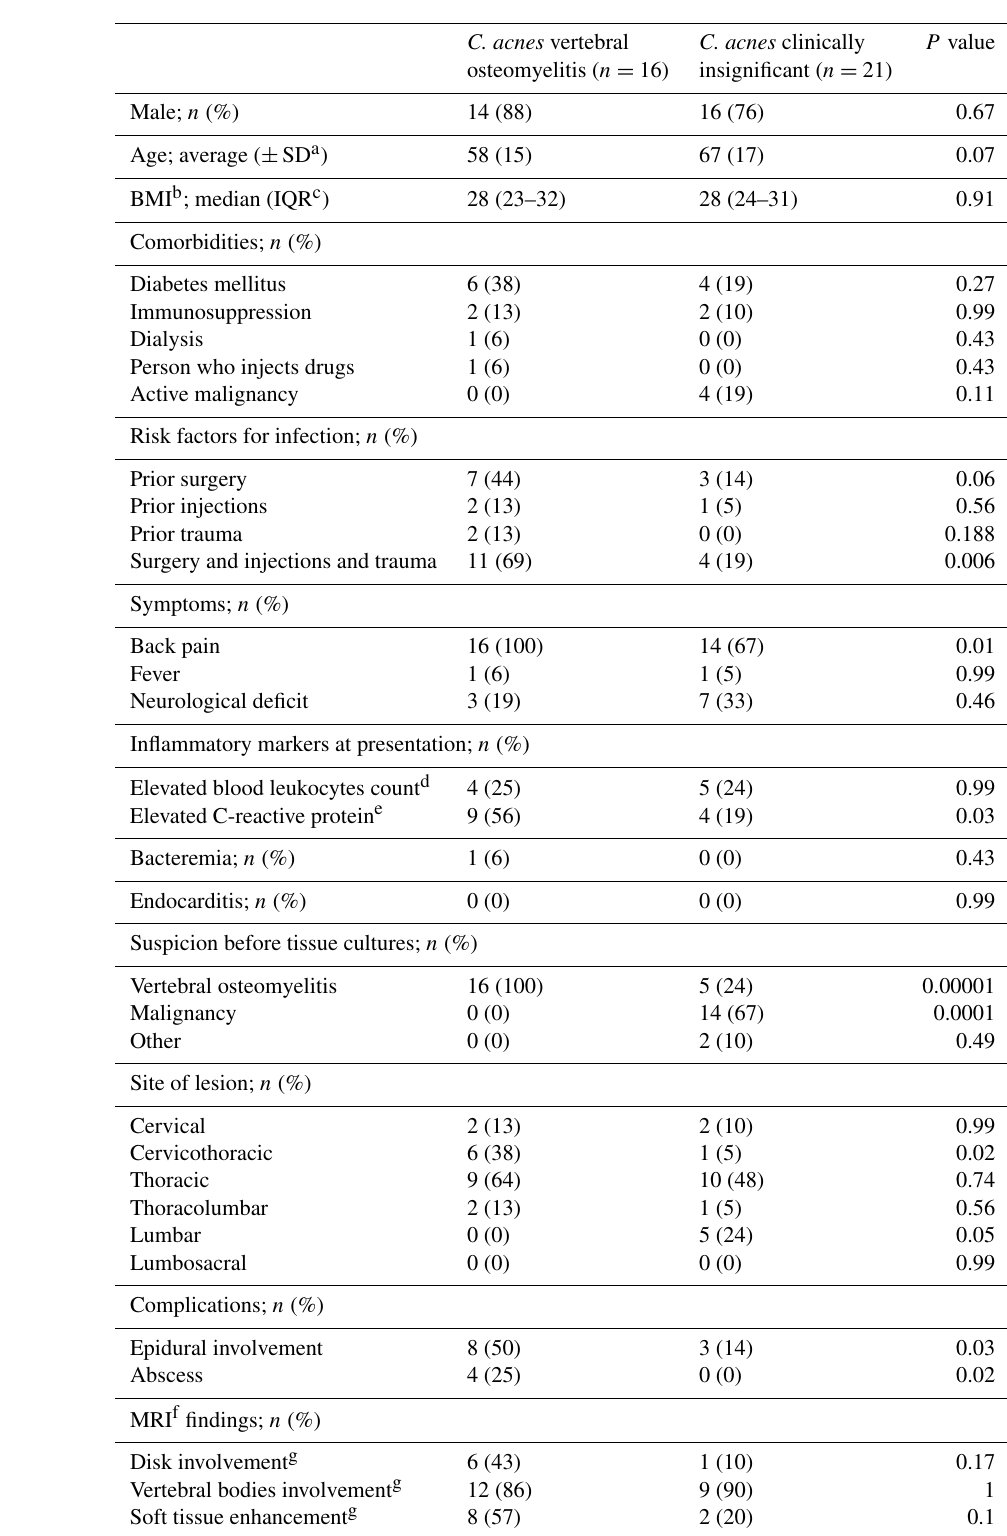
Table 1. Clinical, demographic, radiological, and microbiological characteristics of patients included in the study. C. acnes